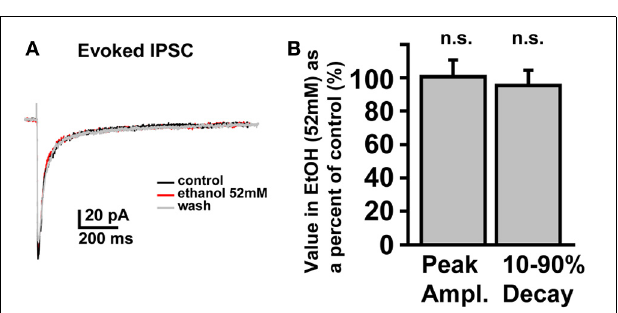
FIGURE 4 | Electrically evoked IPSCs are not affected by EtOH. (A) Example trace showing that an eIPSC in an NHP GC is not affected by EtOH (52mM). (B) Plot of the mean percent change, induced by EtOH (52mM), of the peak amplitude (left bar) and 10–90% decay time (right bar) of eIPSCs in NHP GCs, normalized to the control values (before and after EtOH), n = 4 GCs from two animals.